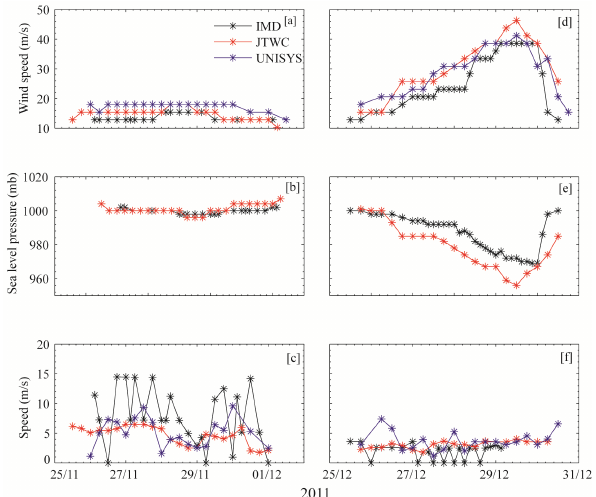
Figure 3. Sea level residual (SLR) at (a) Ratnagiri, (b) Verem, (c) Karwar, (d) Tuticorin, (e) Mandapam, (f) Gopalpur, (g) Gan- gavaram, (h) Kakinada and (i) Port